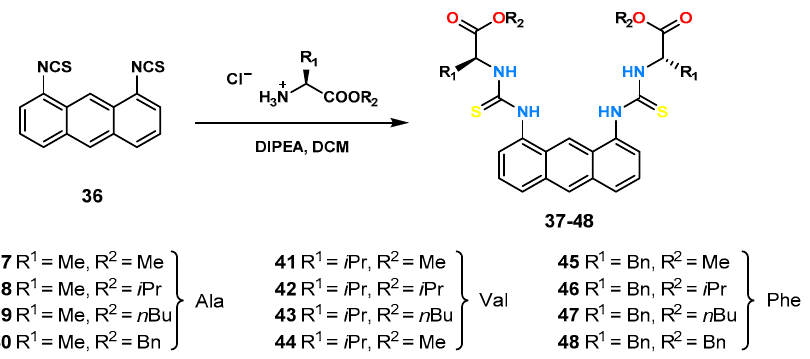
Figure 14. A family of 1,10-Dithiourea anthracene receptors 37–48 decorated with α -amino acids.